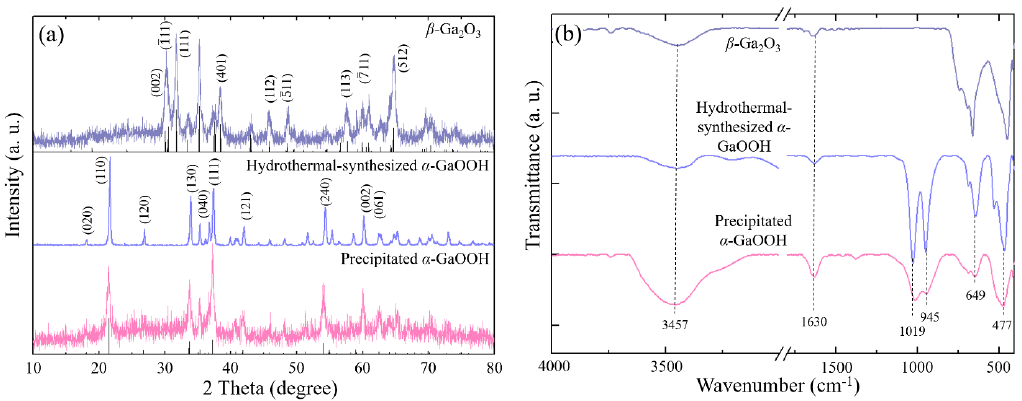
Figure 4. ( a ) XRD patterns and ( b ) FTIR spectra of the precipitated α-GaOOH nanorods with 2 h of aging, hydrothermal-synthesized α-GaOOH nanorods at 140 °C for 10 h, and β -Ga 2 O 3 nanorods with 2 h of aging followed by the hydrothermal synthesis and calcination at 1000 °C for 5 h. It was noted that aside from the 2-h aging sample, 10-min, 1-h, 1.5-h, 2.5-h, 3-h, and 6-h samples were also examined using XRD and FTIR, but no noticeable changes were observed in the ranges from 1 h to 6